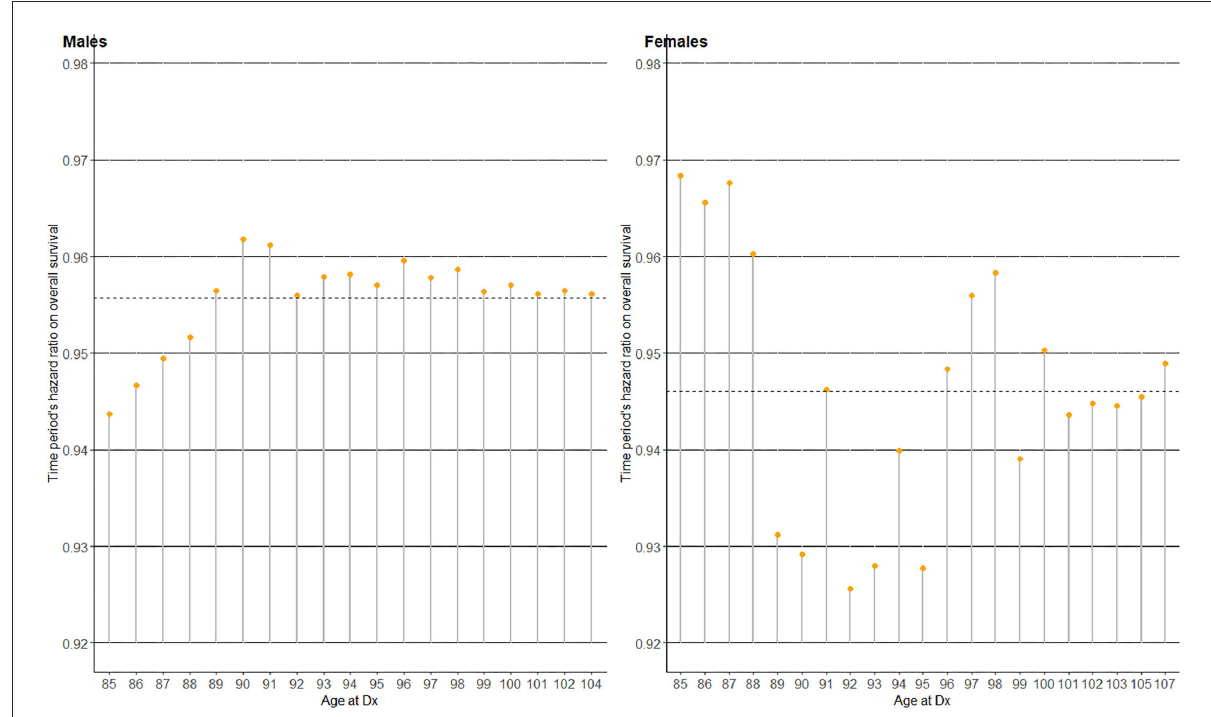
FIGURE4 Time period’s hazard ratio (HR) on overall survival (OS) for the four time periods in 2005–2012, among the oldest old (age at Dx 85 with gastric cancer in